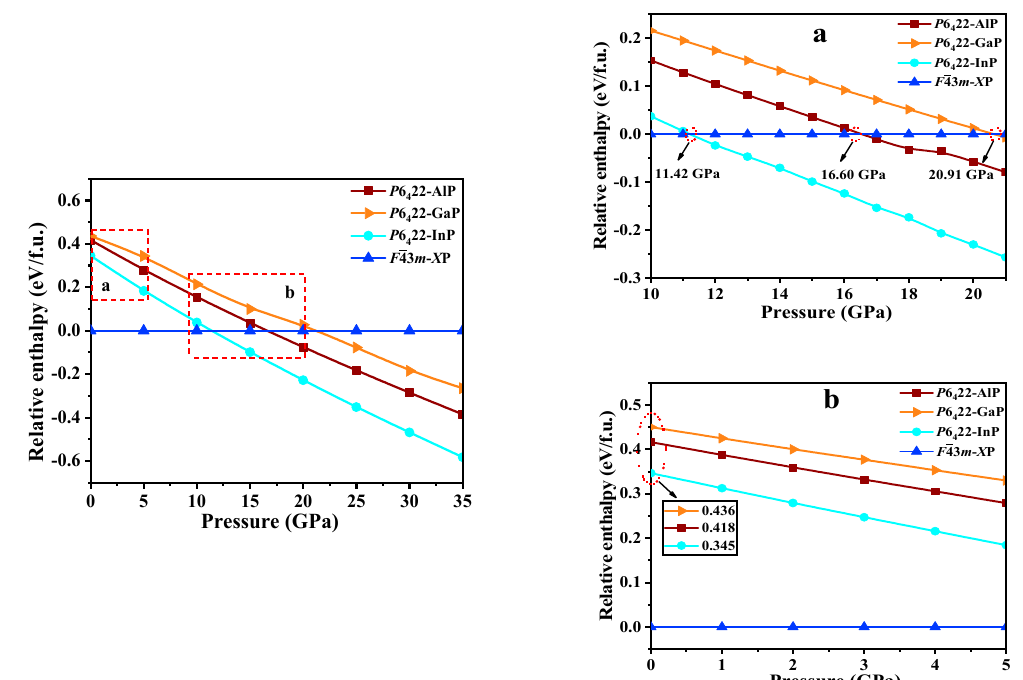
Figure 5. The relative formation enthalpies curves (relative to F 43 m - X P) as a function of pressure (0 to 35 GPa) for P 6 4 22- X P ( X = Al, Ga, or In); ( a , b ) are the zoomed in views of selected areas. Table 2. The calculated elastic constants ( C 11 , C 12 , C 13 , C 33 , C 44 , C 66 ), bulk moduli B , shear moduli G , Young's modulus E (GPa), Poisson’s ratios ʋ and universal anisotropic index A U for P 6 4 22- X P ( X = Al, Ga, or In) when pressure P (GPa) increases from 0 to 35 GPa via the method of GGA-PBE.